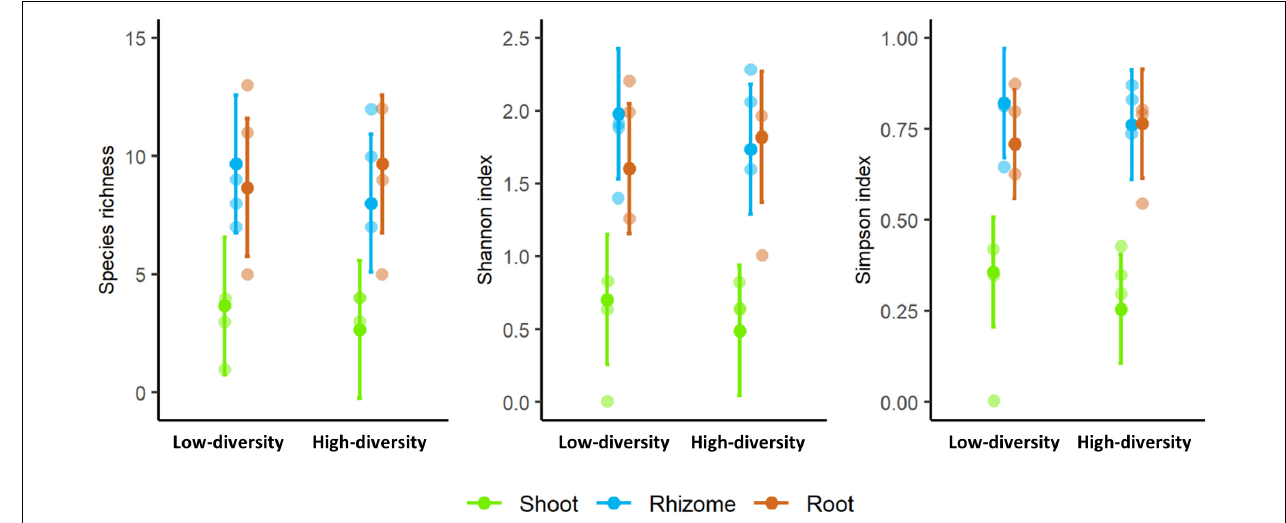
FIGURE 4 | Species richness and diversity indexes (Shannon and Simpson) of the mycobiome of shoots, rhizomes, and roots of Brachypodium rupestre in low and high-diversity grasslands.